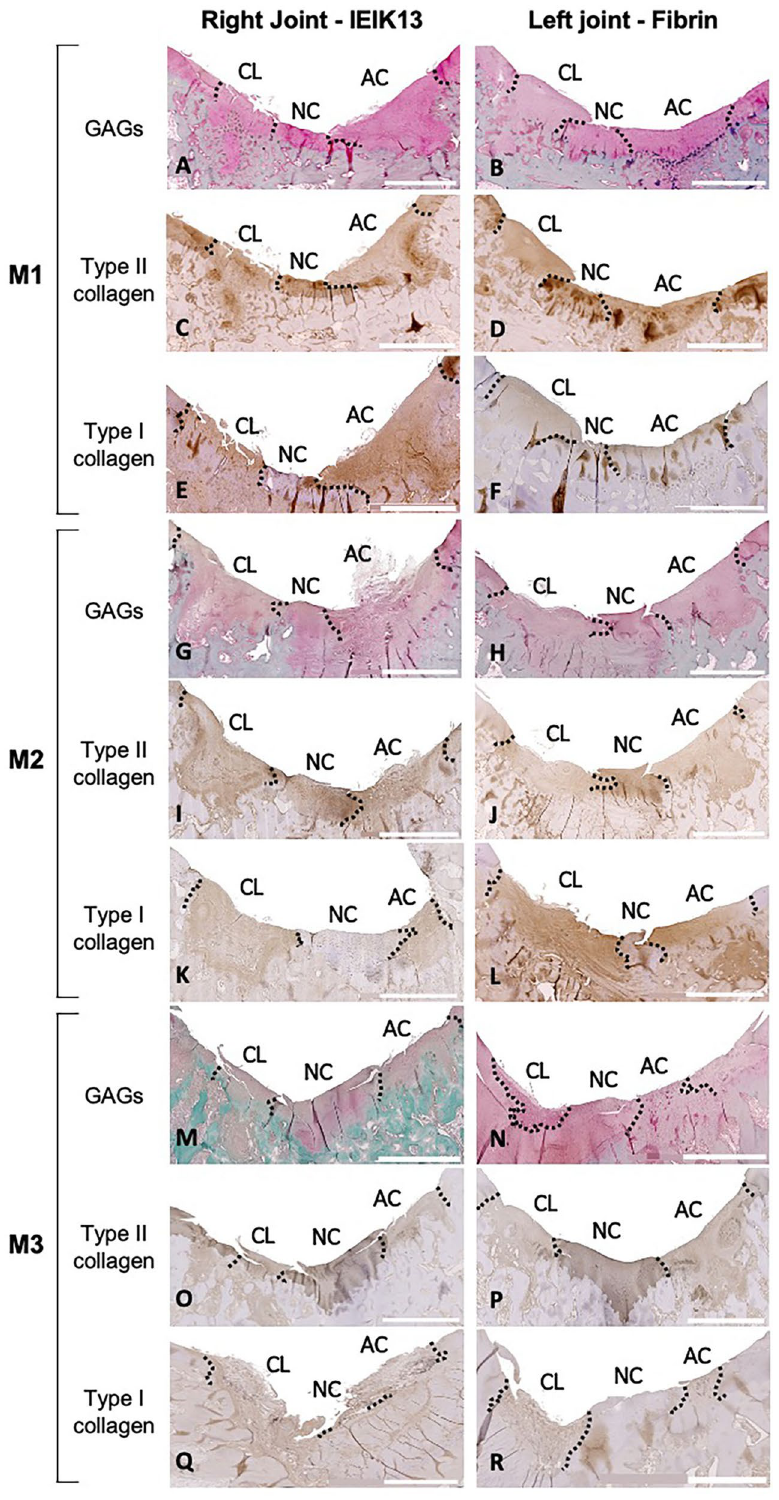
Figure 7. Histological characterization of the reparative tissues in femoral condyles of M1, M2 and M3 monkeys, as indicated. GAG staining and type I and type II collagen immunostaining are shown on coronal sections. The hydrogel type and the anatomical site of implantation are indicated ( CL Cell-loaded, NC Native Cartilage, AC Acellular, scale bar: 2 mm). The boundaries between the implants and the surrounding cartilage are represented by dotted